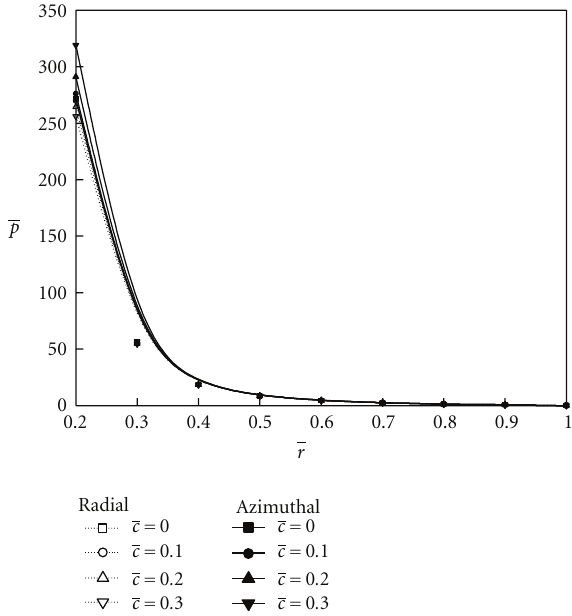
Figure 3: Variation of nondimensional mean film pressure p with r for di ff erent values of l with β = 0 . 05, M = 2, c = 0 . 3, and ψ = 0 . 01.